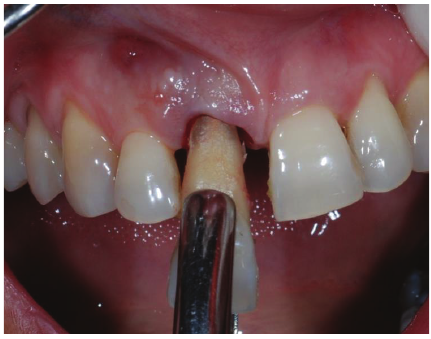
Figure 3: Plaque and calculus can be observed on the root surface at the time of extraction, performed with minimal trauma.